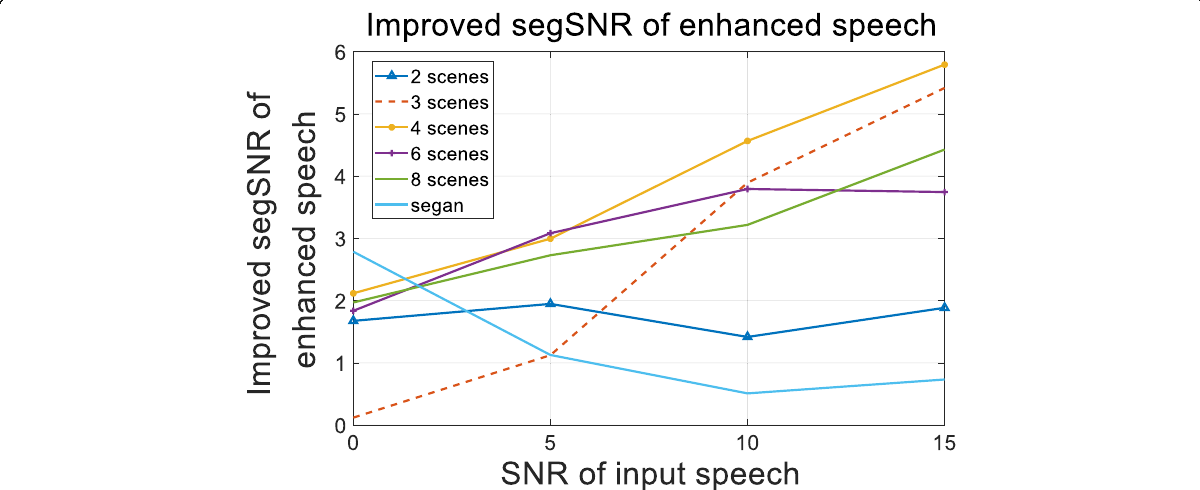
Fig. 7 The segSNR of enhancement speech. It describes the segmented SNR of enhanced speech in different scenes in two models. By calculating the mean, the improved model achieves mean value 4.28 gain in the segSNR on WCGAN and achieves 1.45 gain on SEGAN